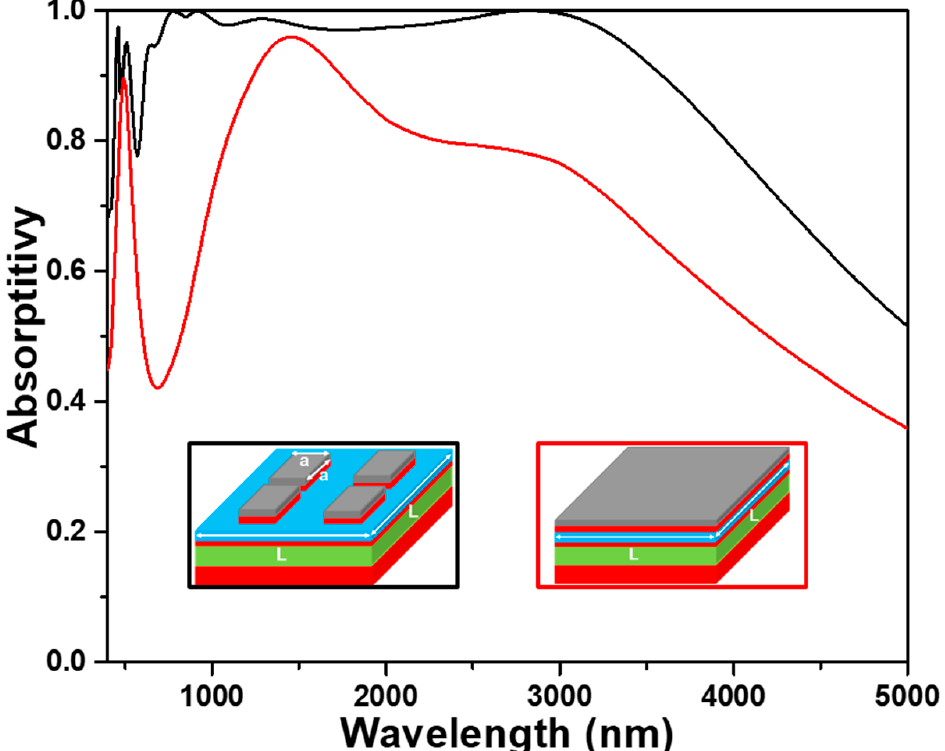
Figure 5. Effect of the TiO 2 and Ti layers with different structures on the absorption properties of the designed absorber. Black line for TiO 2 (t1) and Ti (t2) layers with a square length of 240 nm and red line for and TiO 2 (t1) and Ti (t2) layers with full planes (550 nm). A FP etalon or interferometer is an optical cavity which can be constructed using two thin mirrors (metals) to form the parallel reflecting surfaces. The two thin mirrors are separated by a lossless dielectric film with the thickness of at least a quarter-wavelength of the incident light. For that, as Figure 1 shows, a FP cavity resonance can be formed by the Ti square cube (t2) and Ti plane film layer (t4) separated by PNIPAAm layer and another FP cavity resonance can be formed by the two Ti plane film layers (t4 and t6) separated by SiO 2 layer. The results in later section will further prove that TiO 2 (t1)-Ti (t2) square cubes can cause the excitation of the LSP resonance and the Ti (t2)-PNIPAAm (t3)-Ti (t4)-SiO 2 (t5)-Ti (t6) layers can cause the excitation of the LSP resonance and the FP cavity resonance in the PNIPAAm and SiO 2 layers. This comparison result further proves that the investigated structure can excite the multiple electromagnetic resonance modes at the same time. Therefore, the absorptivity and average absorptivity of the proposed absorber are much better than those of absorber with the six-layer continuous plane films due to the enhancements of the synergy resonances of the LSP and FP cavity in the red light and NIR band of analyzed